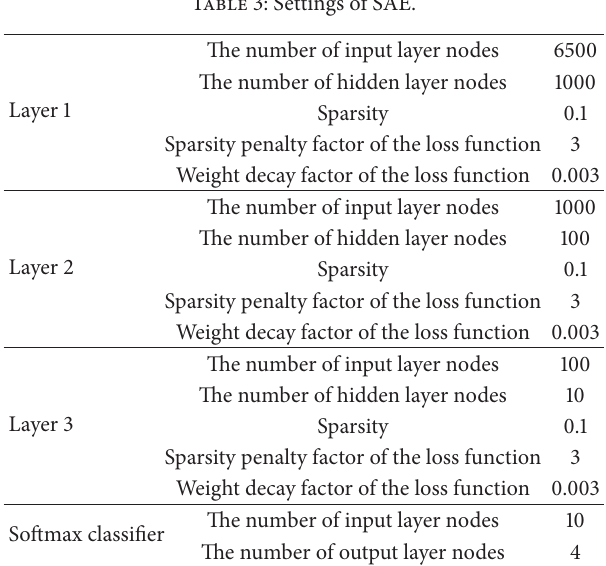
Table 3: Settings of